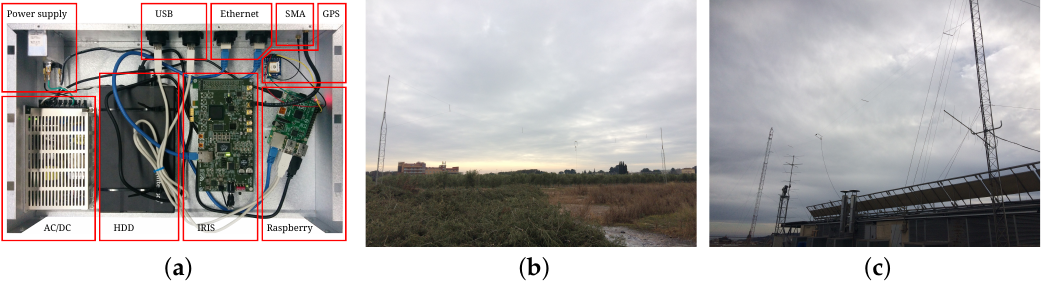
Figure 10. Low cost transmitter installed in Cambrils, Spain, 400 km away from the receiver, Barcelona, to test NVIS radio-communications: ( a ) a picture of the whole digital radio-modem based on the IRIS platform; ( b ) the wideband HF folded dipole placed at the transmitter side; ( c ) the wideband HF folded antenna with the balun placed in the receiver side.